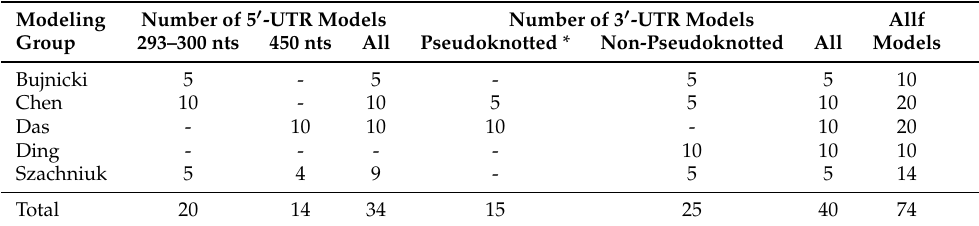
Modeling Number of 5 (cid:48) -UTR